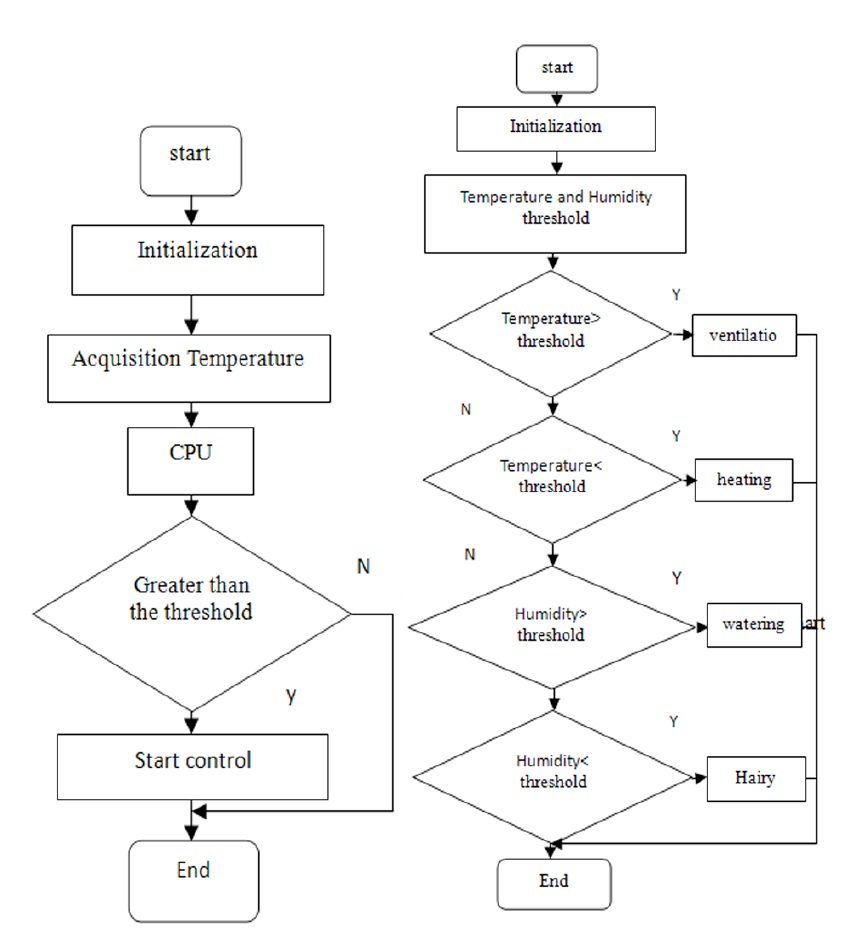
Figure 5. A flow chart for collecting data Figure 6. Temperature and humidity control flow